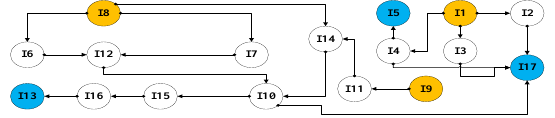
Table 9 . Case study step-by-step time